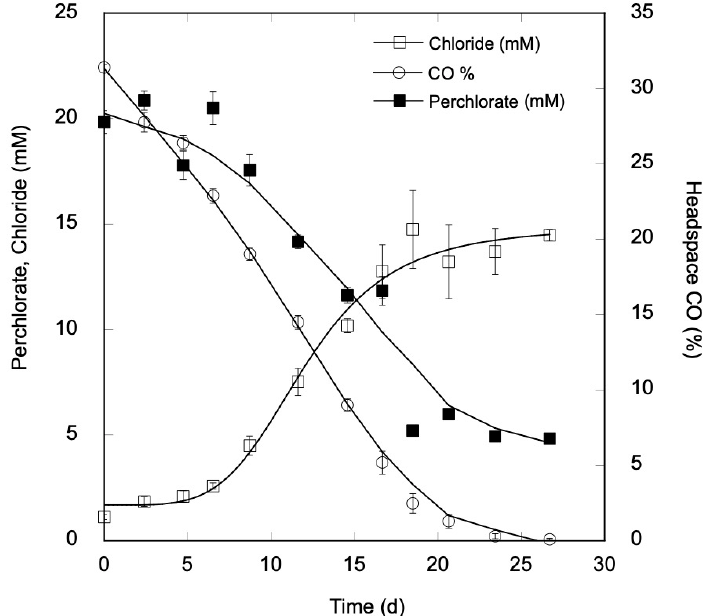
Figure 2. Uptake of CO (open circles) perchlorate (closed circles) and chloride production (open squares) by Moorella glycerini DSM 11254 T incubated with 20 mM perchlorate and a headspace containing 30% carbon monoxide. Data are means of triplicate determinations with ±1 standard error.